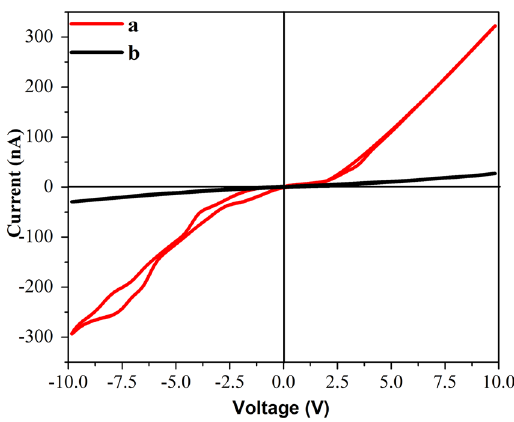
Figure 10. The current generation as a function of applied voltage under UV light exposure over ( a ) anatase, and ( b ) rutile TiO 2